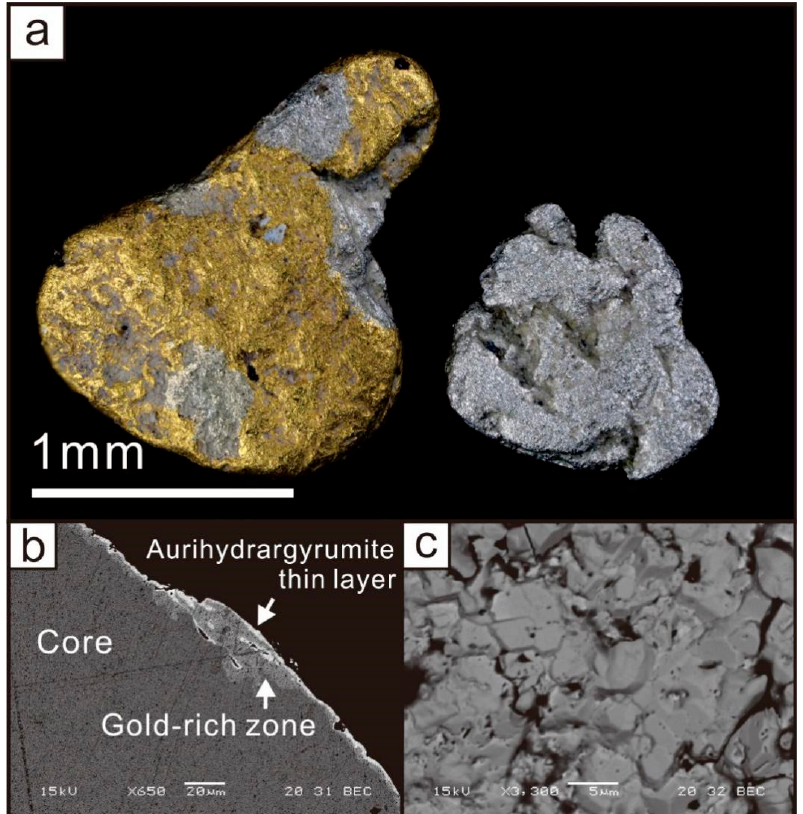
Figure 1. Geological map and water system of the investigated area, southwest Ehime Prefecture, Shikoku Island, Japan.